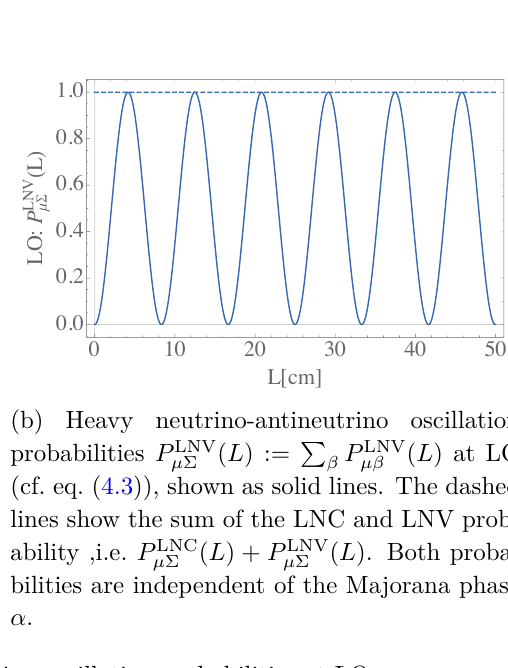
Figure 2. Heavy neutrino-antineutrino oscillation probabilities at LO.